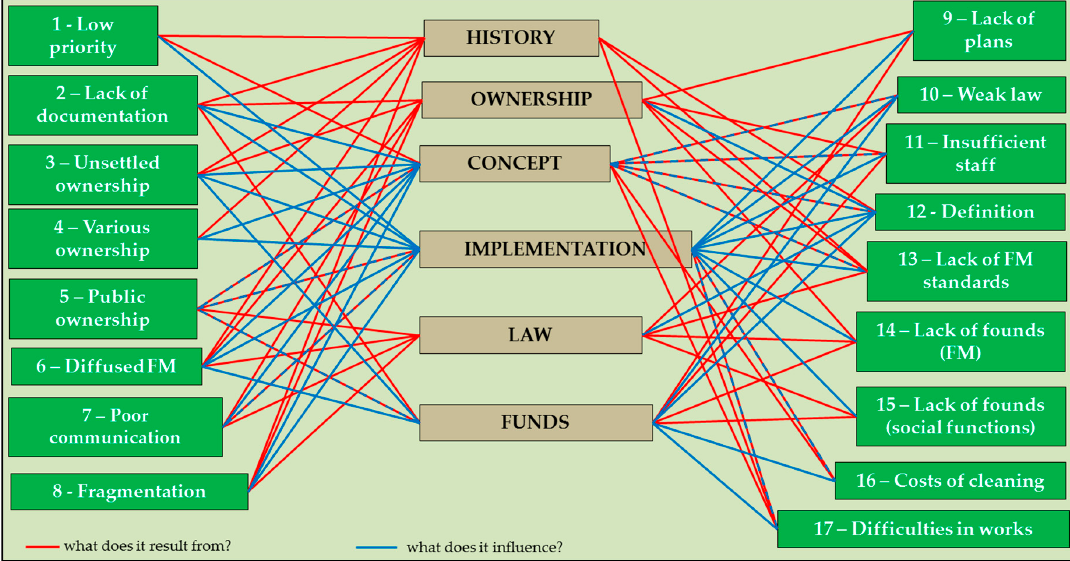
Figure 2. The analysis of forest management problems from Table 1.